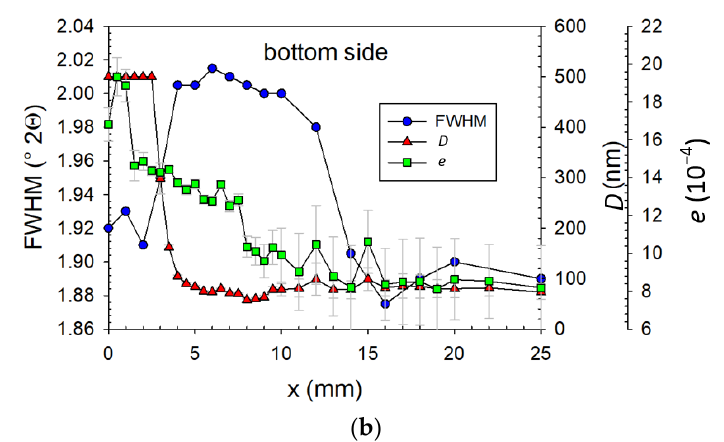
Figure 4. ( a , b ) Dependence of FWHM parameter, crystallite size D , and microdeformation e on the distance from the weld axis.